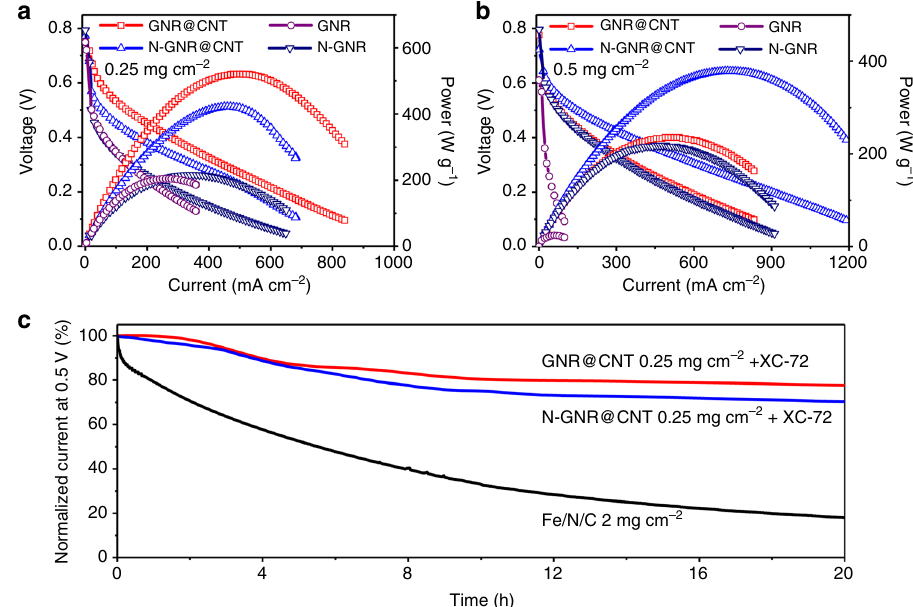
Fig. 4 Proton exchange membrane fuel cell evaluation. Polarization and power density curves of graphene nanoribbons on carbon nanotubes (GNR@CNT), N-doped GNR@CNT (N-GNR@CNT), and N-doped graphene nanoribbons (N-GNR) as a function of the areal current density with cathode catalyst loading of a 0.25 mg cm − 2 and b 0.50 mg cm − 2 in a proton exchange membrane fuel cell (PEMFC); c stability of the indicated catalysts in PEMFC measured at 0.5 V. The absolute current densities before durability tests (at 100%) were 136, 80 and 1216 mA cm − 2 for graphene nanoribbons on carbon nanotube (GNR@CNT), nitrogen-doped catalyst (N-GNR@CNT), and reference catalyst iron-nitrogen-carbon (Fe/N/C), respectively. Weight ratio of Na fi on/ catalyst/carbon black (XC-72) = 5/1/4. Cell: 80 °C; H 2 /O 2 : 80 °C, 100% relative humidity, 2 bar back